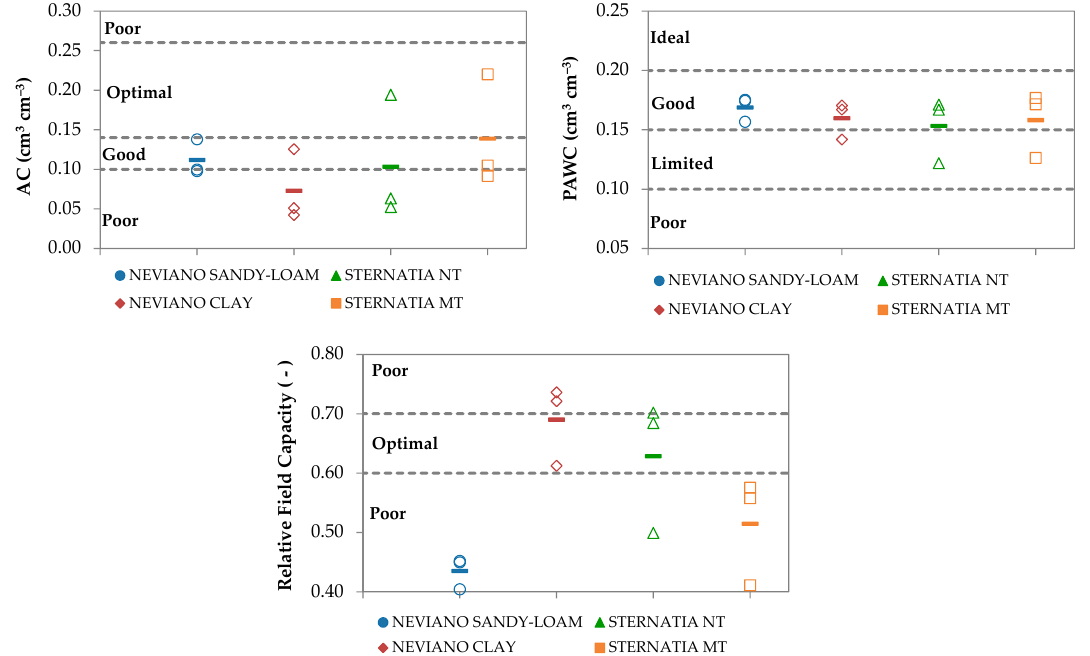
Figure 10. Air capacity (AC), plant available water capacity (PAWC), and relative field capacity (RFC) values. Open symbols represent discrete values and lines mean values. The optimal range or critical limits as suggested in the literature were represented with dashed lines.